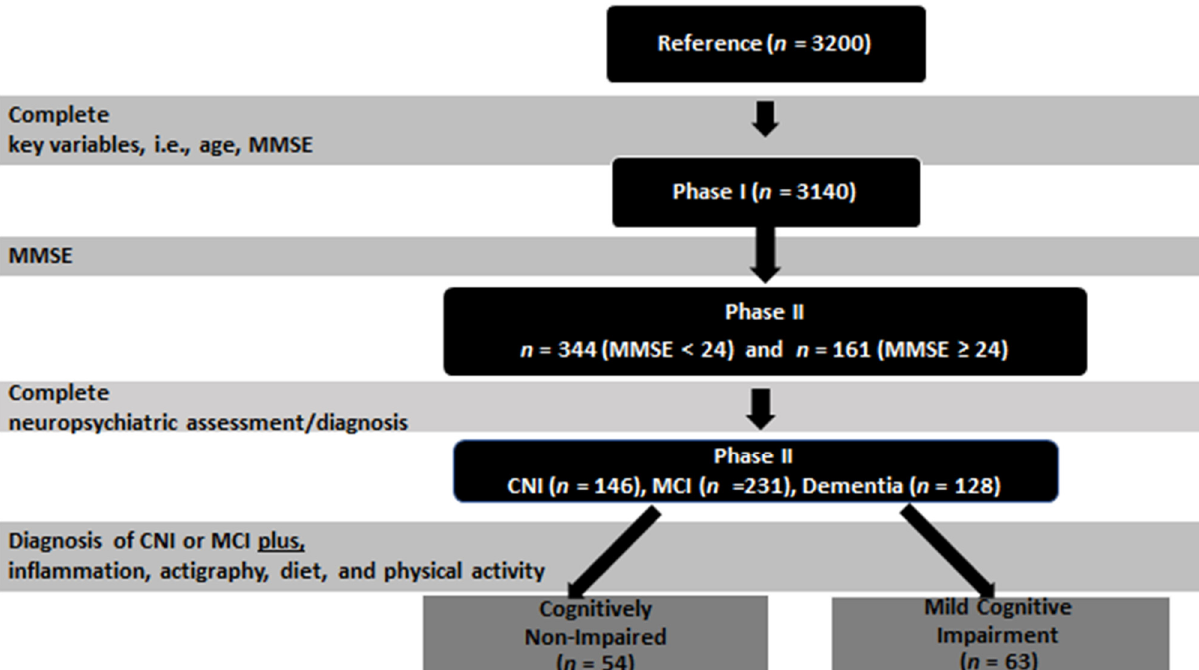
Figure 1. Study flowchart. Abbreviations; MMSE: Mini Mental State Examination, CNI: cognitively non-impaired, MCI: mild cognitive impairment.